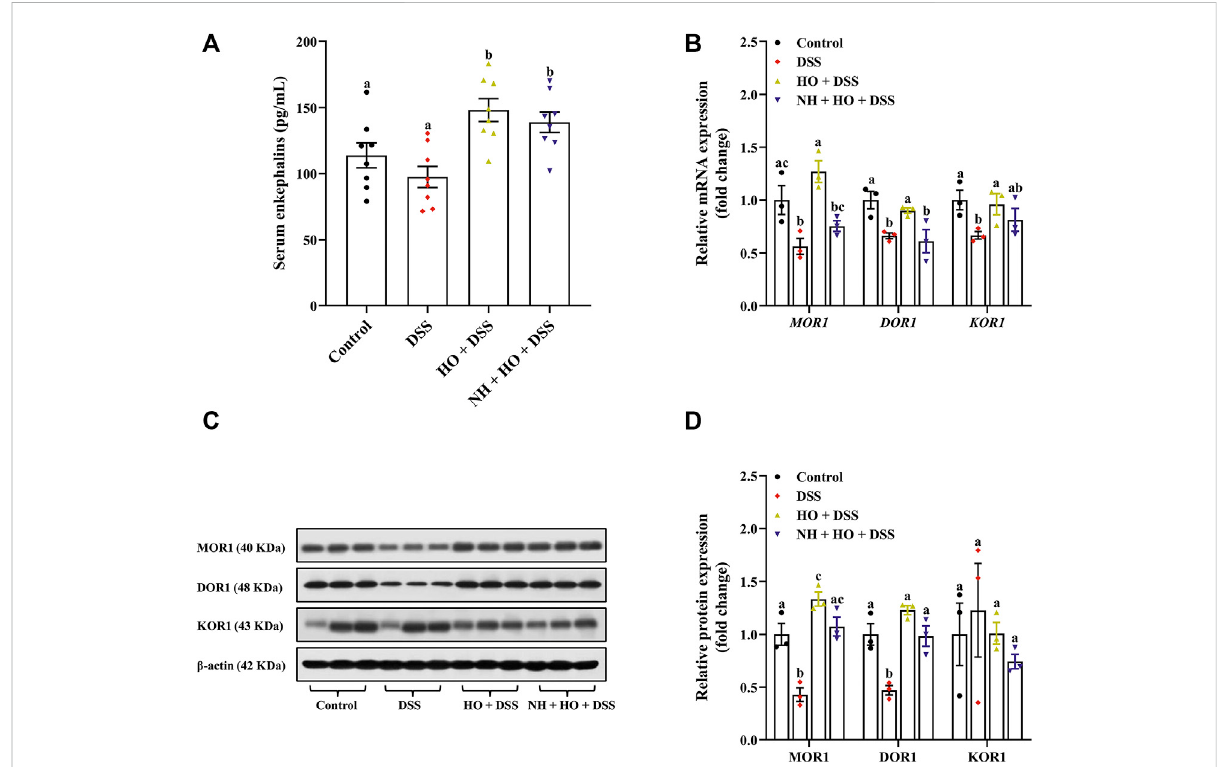
FIGURE 6 Effects of HO treatment on serum enkephalins concentration and expression of opioid receptors in DSS-exposed mice. (A) Serum enkephalins level. (B) Relative gene expression of opioid receptors in the colon. (C) Western blot analysis of opioid receptors expression in the colon. (D) Quantitative analysis of the relative contents of opioid receptors. The data are expressed as mean ± S.E.M. ( n = 3 – 8). Bars with different letters represent signi fi cant differences between groups by Fish ’ s LSD test ( p <